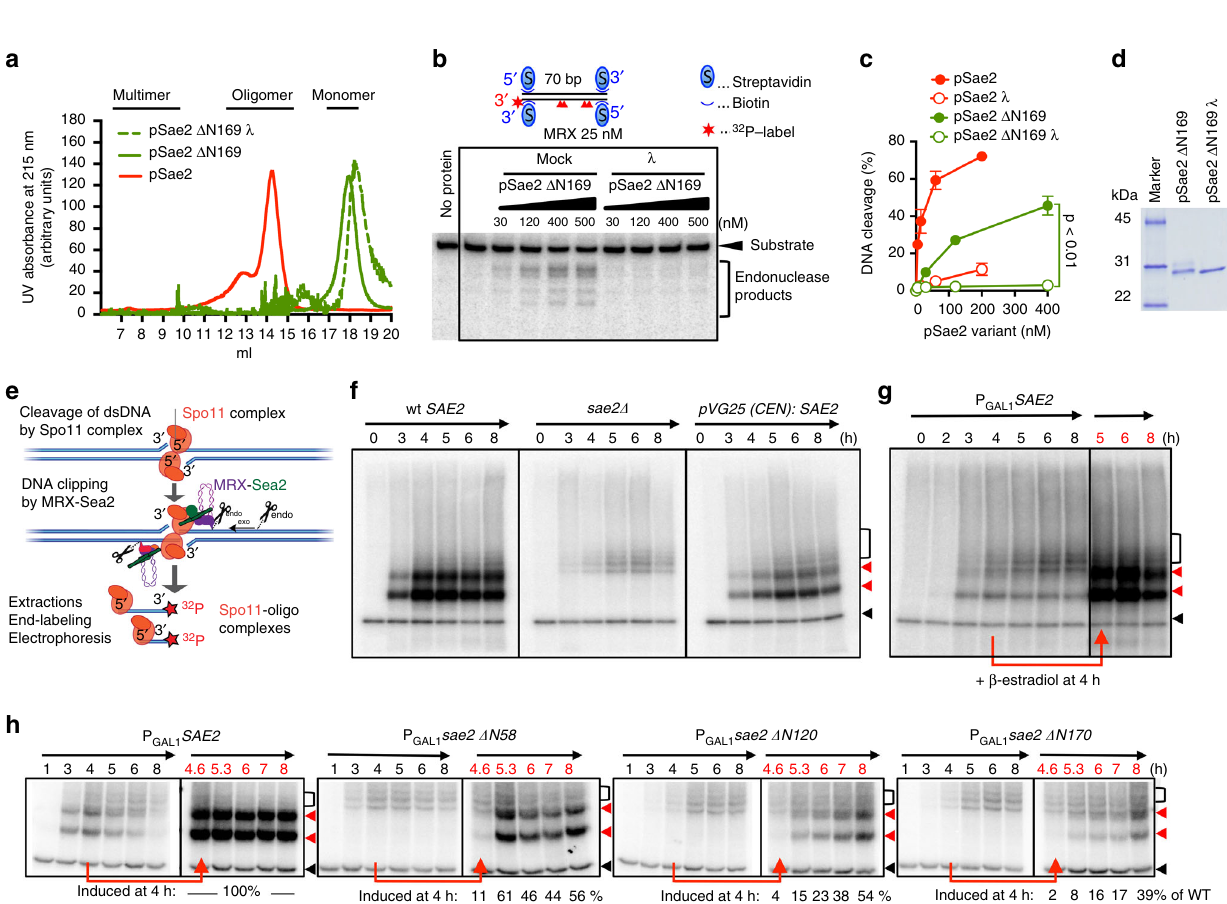
Fig. 2 Sae2 oligomerization is required to promote the MRX nuclease in vitro and in vivo. a Size exclusion chromatography pro fi le of the C-terminal domain of pSae2 (pSae2 Δ N169, residues 170 – 345) prepared with phosphatase inhibitors and either mock-treated (pSae2 Δ N169, green) or dephosphorylated with λ phosphatase (pSae2 Δ N169 λ , green dashed). The pro fi le of full-length pSae2 (same as in Fig. 1h) is shown for reference. b Representative nuclease assays with pSae2 Δ N169 treated or not with λ phosphatase and MRX. c Quantitation of assays such as shown in b ; error bars, SEM, n ≥ 4. d Coomassie- stained polyacrylamide gel showing pSae2 Δ N169 treated or not with λ phosphatase. e A scheme of the Spo11-oligonucleotide assay. See text for details. f Spo11-oligonucleotide assay performed with wt SAE2 (left), sae2 Δ (middle), or wt SAE2 expressed from a centromeric plasmid under the control of its natural promoter and terminator (right). The red triangles mark the long and short Spo11-oligonucleotide species generated in wild-type cells. The open bracket marks MRX-Sae2-independent “ double-cut ” Spo11-oligonucleotide species observed in wild type and sae2 Δ (D.J., V.G., and M.J.N, manuscript in preparation). The black triangle marks a non-speci fi c terminal deoxynucleotidyl transferase band. g – h Spo11-oligonucleotide assay as in f , performed in sae2 Δ cells with wt SAE2 or N-terminal truncations expressed from an inducible promoter 4 h after the onset of meiosis. Samples from uninduced cells are labeled in black; samples from cells induced with β -estradiol are labeled in red. The numbers below represent the amount of Spo11-oligonucleotides relative to wild Δ N169 and pSae2 Δ N169 λ , Fig. 2a). This stands in contrast to analysis. The deletion of 169 residues from the N-terminus of pSae2 pSae2 Δ C95, lacking 95 C-terminal residues, which eluted as very abolished self-interaction and the pSae2 Δ N169 in gel fi ltration large multimeric species with a broad distribution in size exclusion experiments migrated as a very small unit likely corresponding to a chromatography (Supplementary Fig. 2d). monomer, irrespectively of its phosphorylation status (pSae2